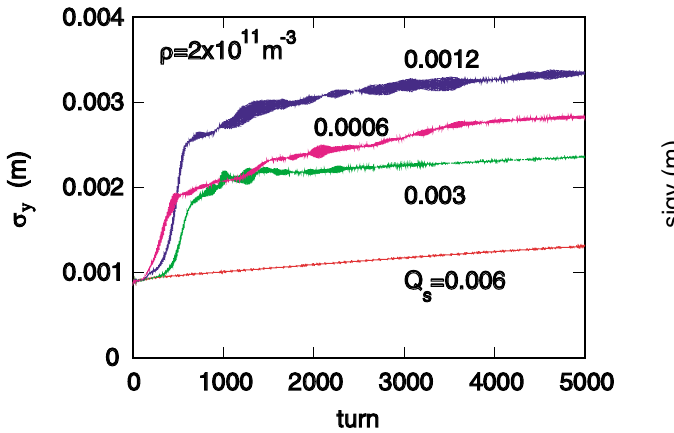
FIG. 39. (Color) Evolution of the LHC vertical beam size at injection with turn number simulated by the code PEHTS for an electron density of 2 (cid:1) 10 11 m (cid:2) 3 [88]; the curves correspond to different synchrotron tunes as